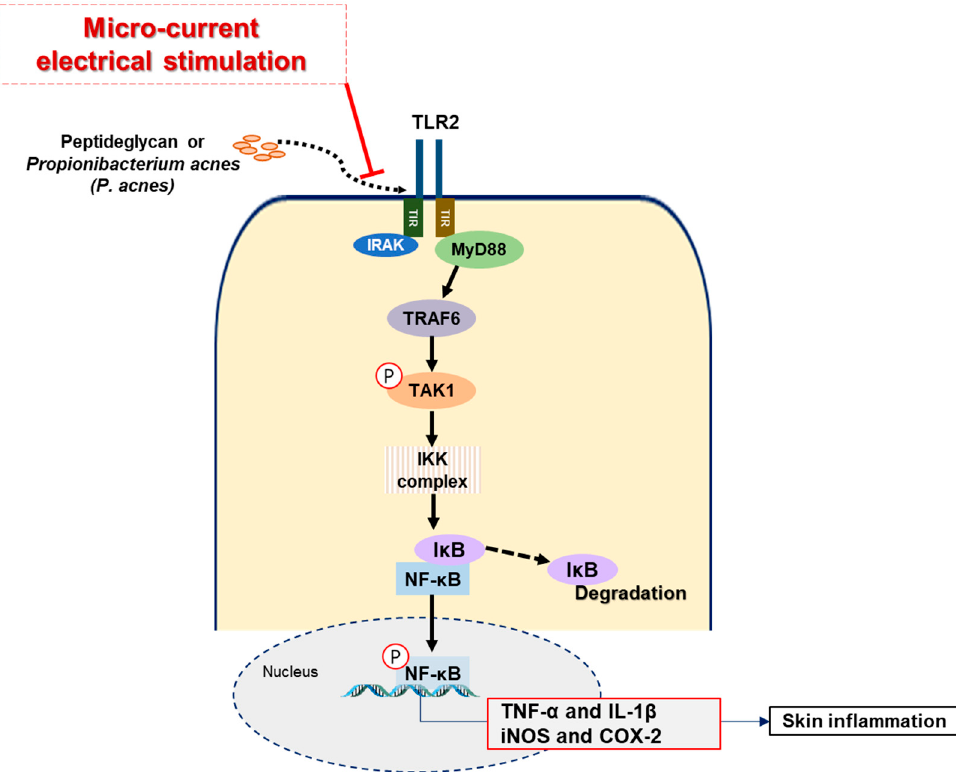
Figure 4. A model of MC in the suppression of PGN or P. acnes -induced inflammatory responses. MC exerts anti-inflammatory effects in acne lesions by downregulating TLR2/NF- κ B signaling pathways.